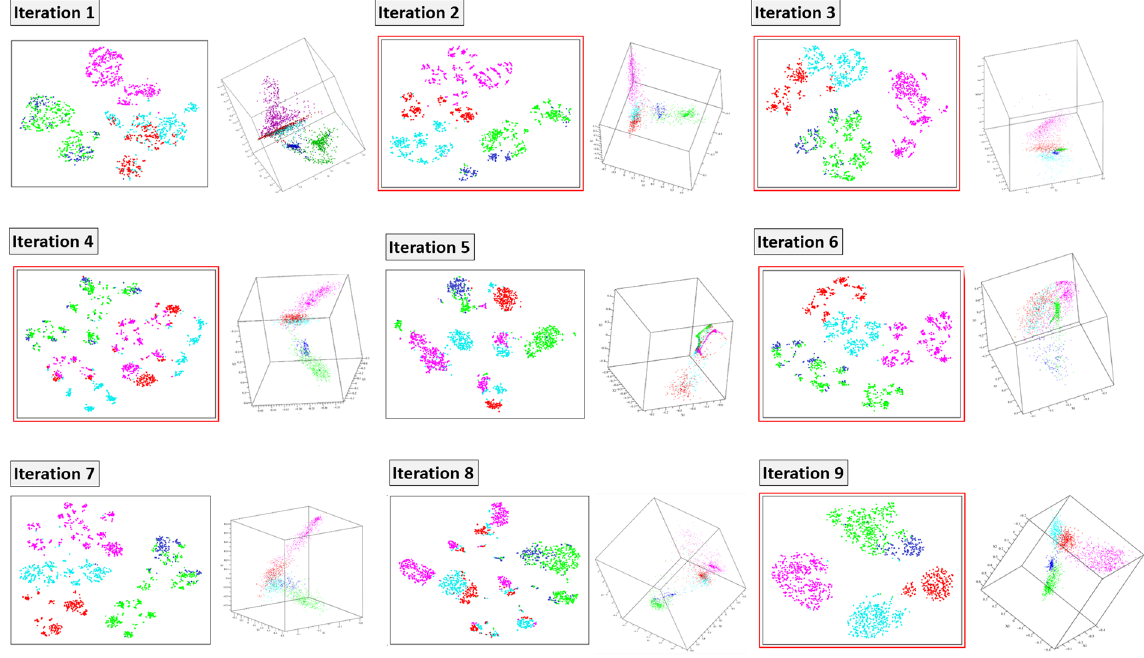
Figure 5. Layer Extraction by DQC Based Feature Selection. Eighteen iterations of DQC based feature selection identified transcripts in windows of decreasing information content. The first nine iterations are shown with a representative t-SNE embedding on the left and a DQC snapshot in the first three dimensions on the right for each iteration. Iteration 1 is the same data as shown in Fig. 1B. The number of transcripts identified with SVD-entropy from iteration 1 to 18: 48, 57, 55, 22, 22, 73, 54, 23, 146, 87, 41, 34, 413, 279, 209, 119, 80, 2102. Iterations in red show repeating patterns in Fig. 7.